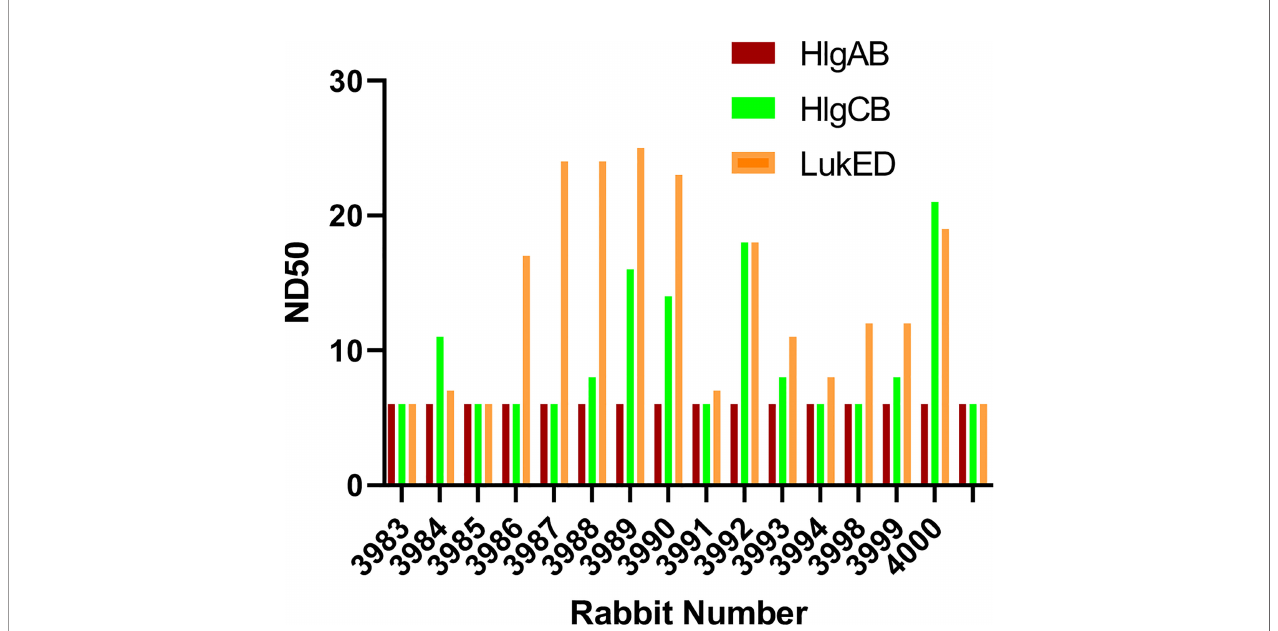
FIGURE 5 | The cross-neutralization of terminal bleeds against other leukocidins. All 15 rabbit samples from terminal bleed were run in full curve and 50% neutralizing dilutions (ND 50 ) were determined for three leukotoxins: HlgAB, HlgCB, and